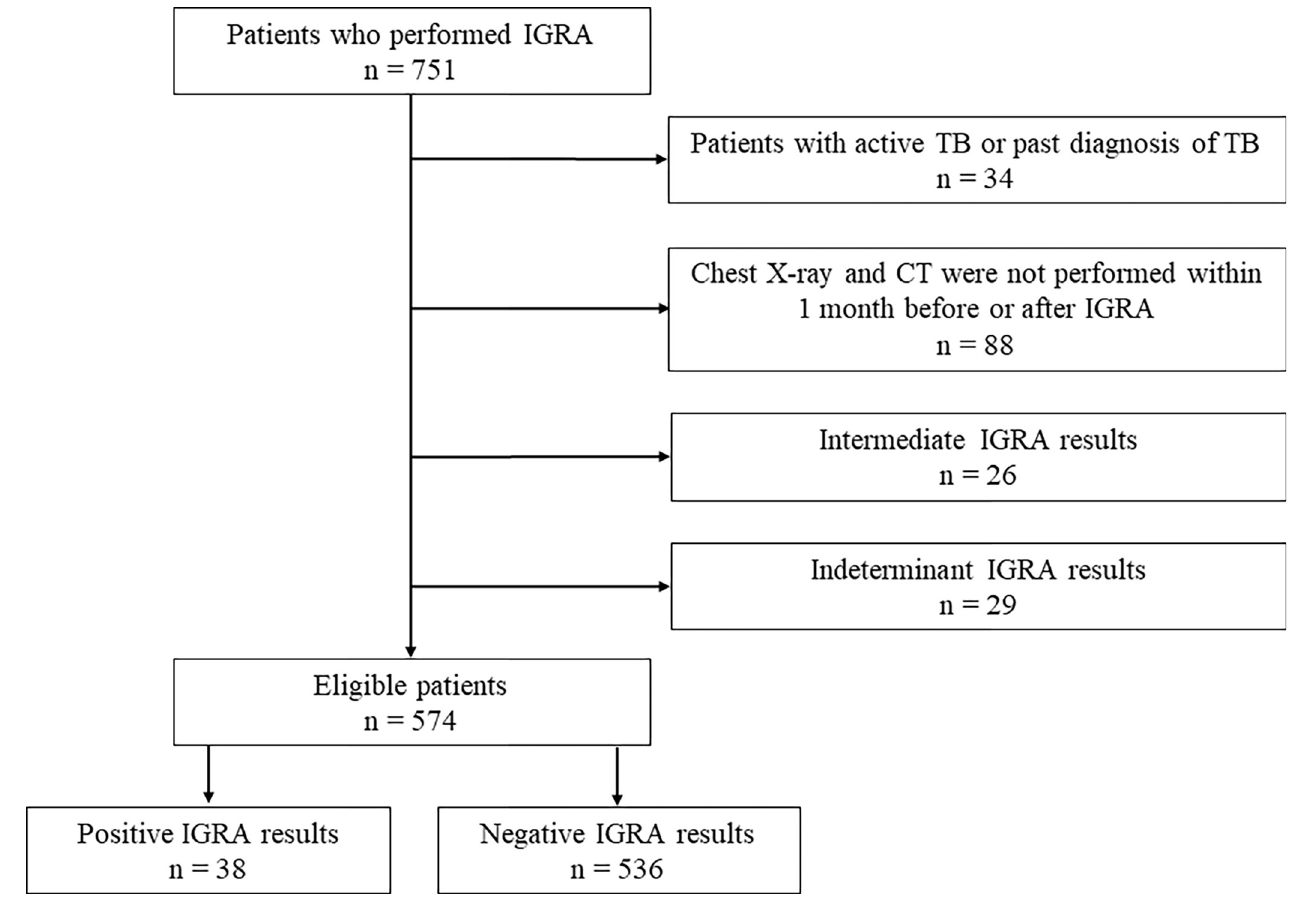
Fig 1. A flow chart of the